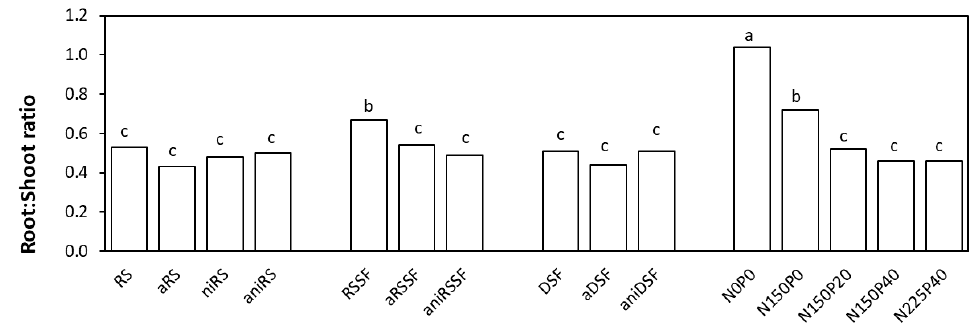
Figure 4. Root:Shoot ratio for untreated and acidified organic products and reference mineral fertilizers 35 days after sowing (DAS) as mean values of 4 replicates. RS: Raw slurry; RSSF: Raw slurry solid fraction; DSF: Digestate solid fraction; a: Acidified; ni: Nitrification inhibitor; ani: acid + ni; NxPy: mineral N and P reference fertilizer at x mg N and y mg P kg − 1 soil. Treatments with di ff erent letters (across all levels) are significantly di ff erent ( p < 0.05) according to the Tukey test.